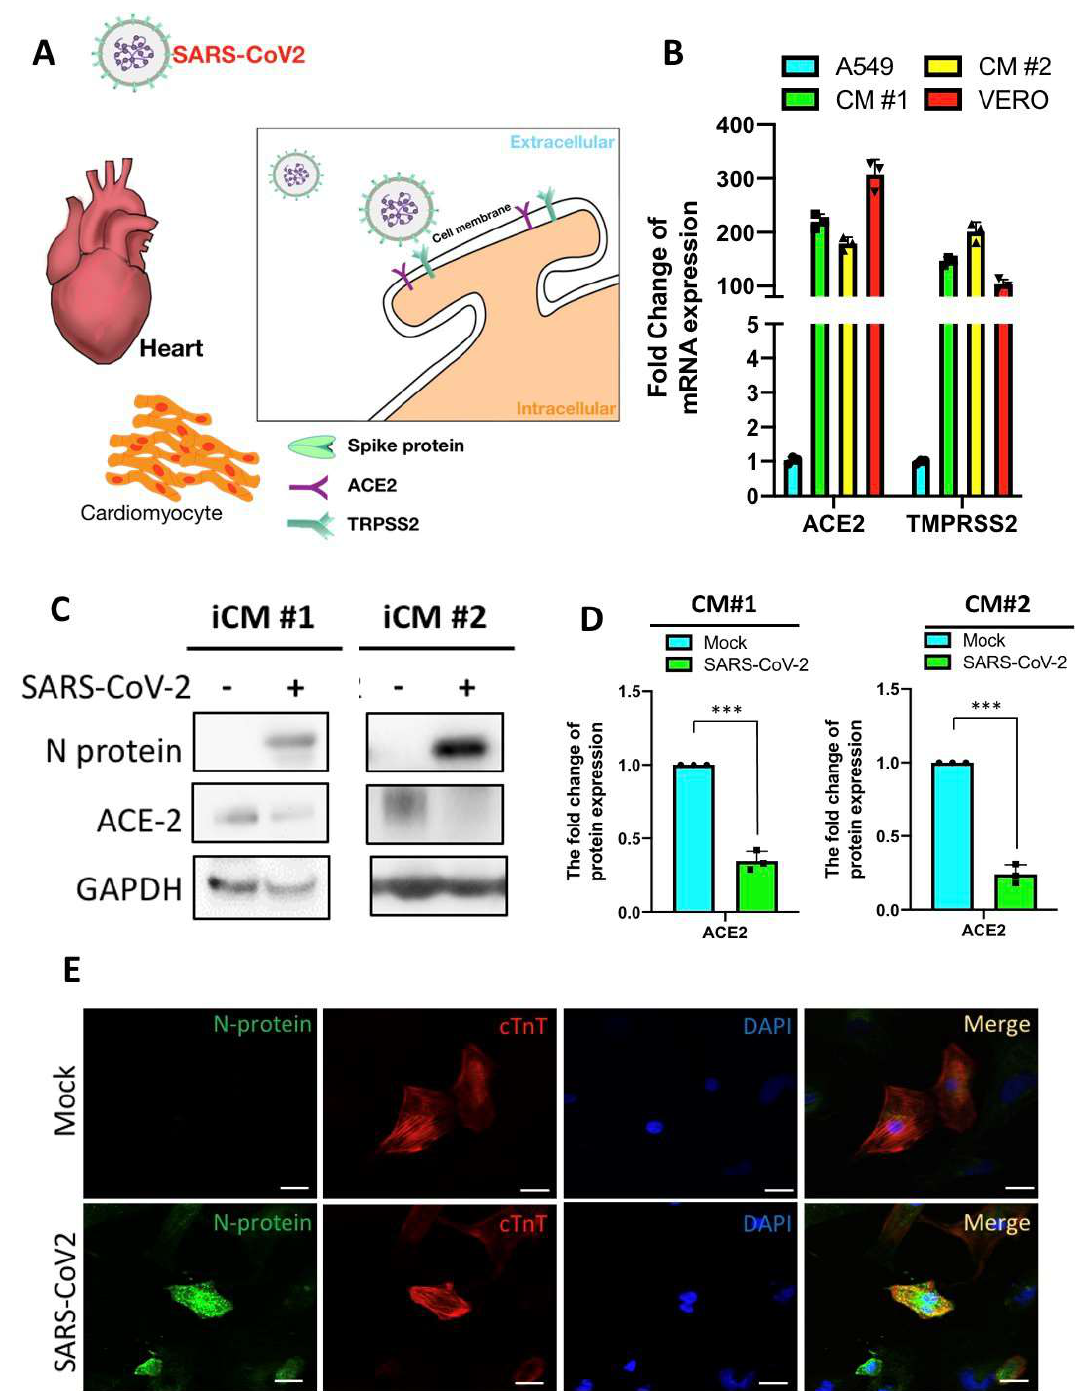
Figure 3. SARS-CoV2 infection in hiPSC-derived cardiomyocytes. ( A ) A proposed scheme for SARS-CoV2 infection in iCMs. ( B ) qRT-PCR showing the expression of ACE2 and TMPRSS2 in iCMs. A549 cells and VERO cells were used as negative- and positive-control cells, respectively. *** p < 0.001 vs. A549. ( C ) Western blot of N protein and ACE2 in iCMs with or without SARS-CoV2 infection. ( D ) The quantifications of Western blots. ( E ) Immunofluorescence staining showed the expression of N protein and cTnT in iCMs with or without SARS-CoV2 infection. Scale bar = 20 μm.